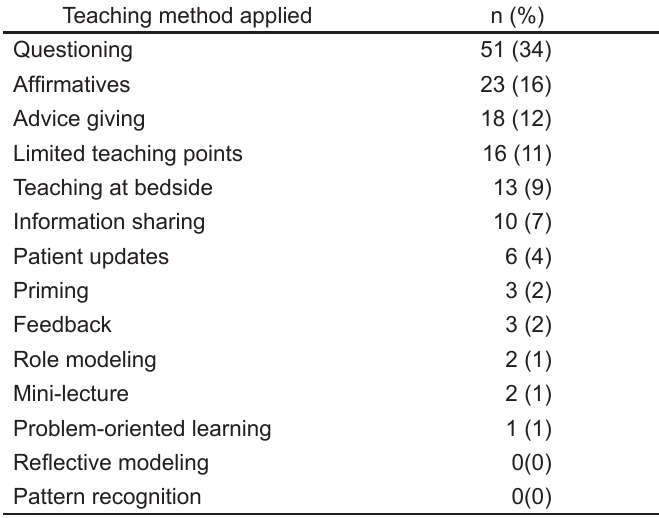
Table 3. Frequency of teaching methods during medical resuscitations n=148 (%).